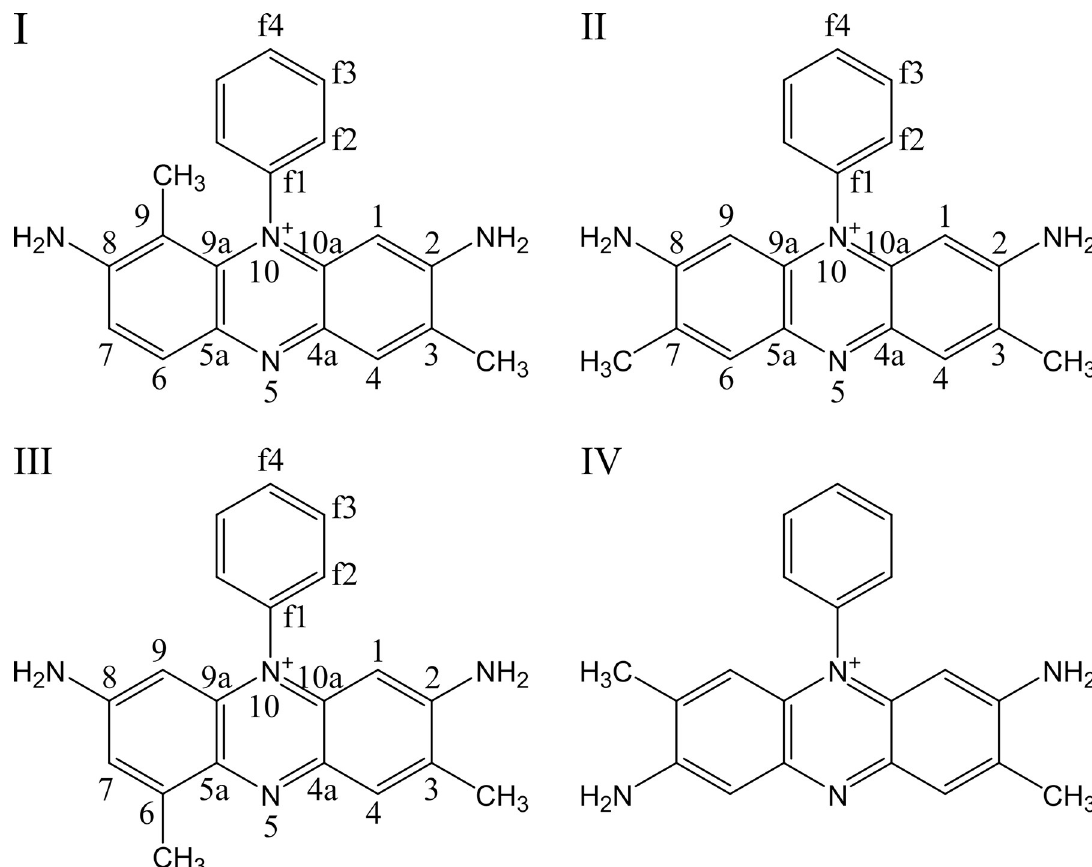
Fig 4. The three major Safranine structures determined by NMR. The number annotations in red refer to the atom assignments done during the analysis of the NMR spectra and follow the biochemical numbering system of flavin and flavin-like molecules. The IUPAC names of the compounds: ( I ) 2,8-diamino-3,9-dimethyl-10-phenylphenazin-10-ium. ( II ) 2,8-diamino-3,7-dimethyl-10-phenylphenazin- 10-ium ( III ) 2,8-diamino-3,6-dimethyl-10-phenylphenazin-10-ium ( IV ) 2,7-diamino-3,8-dimethyl-10-phenylphenazin-10-ium–an alternate possible structure of III ruled out on the basis of the 1,1 ADEQUATE spectrum depicted in Fig 5